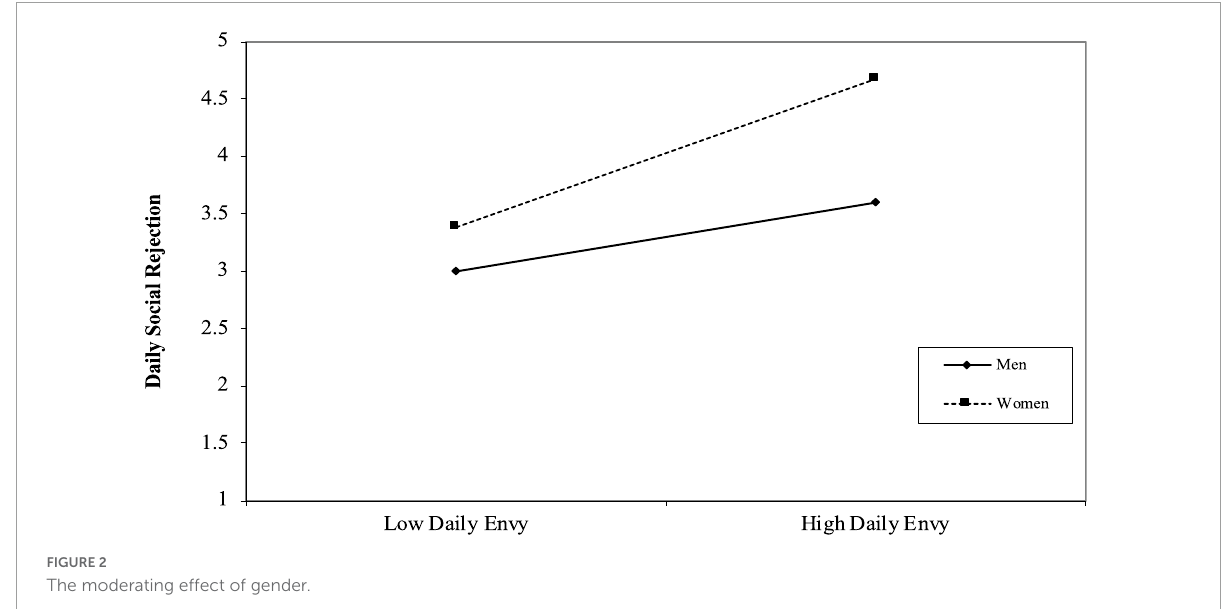
FIGURE2 The moderating effect of